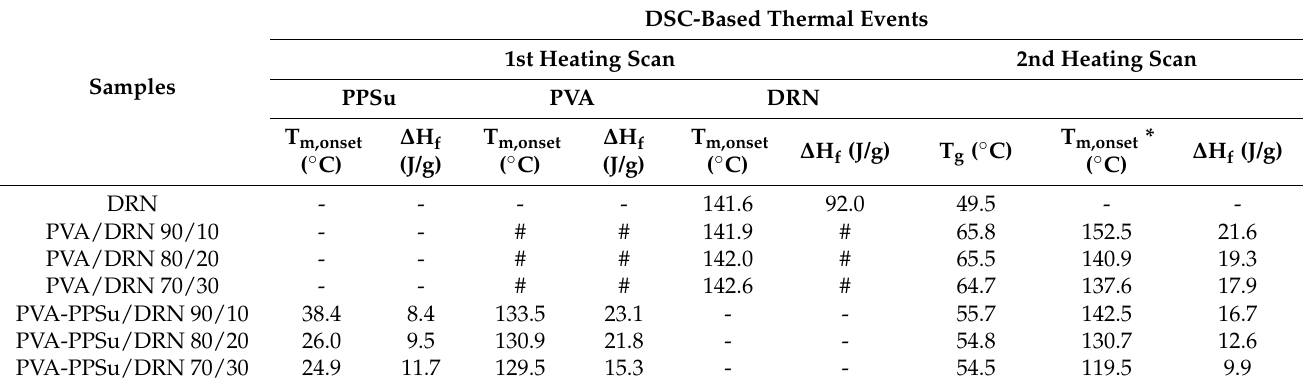
Table 2. Melting onset temperature (T m,onset ), glass transition temperature (T g ) and enthalpy of fusion ( ∆ H f ) results based on the obtained DSC thermograms for the PVA/DVR and PVA-PPSu/DRN ASDs.